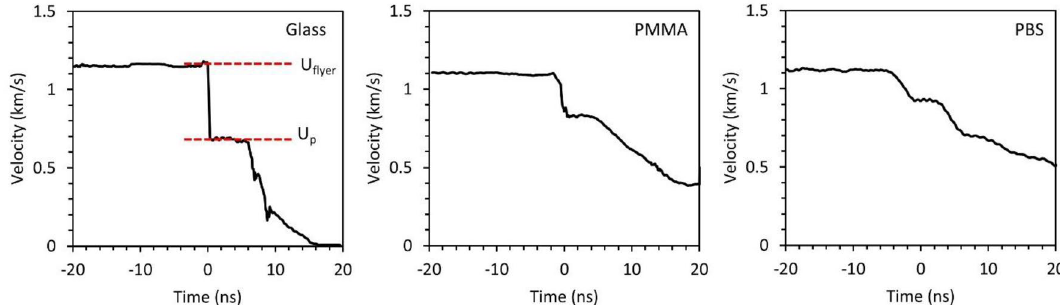
Figure 2. Illustrations of the velocity profiles of 25 μm flyers during travel and the impact on the glass, PMMA, and PBS samples obtained using photon Doppler velocimetry at an impact velocity of 1.2 km/s.